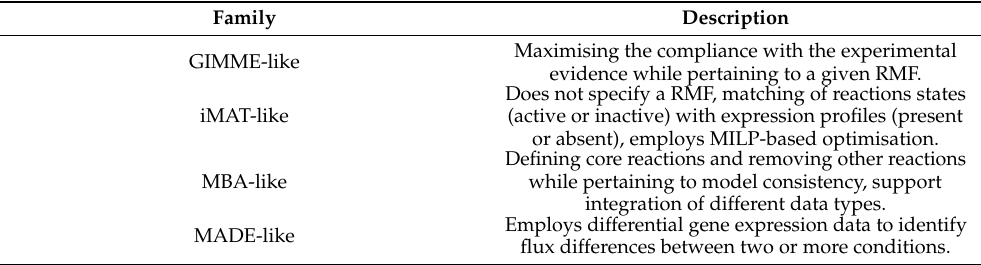
Table 1. An overview of different families of algorithms for context-specific model reconstruction. Abbreviations: RMF—required metabolic function; MILP–mixed integer linear programming.